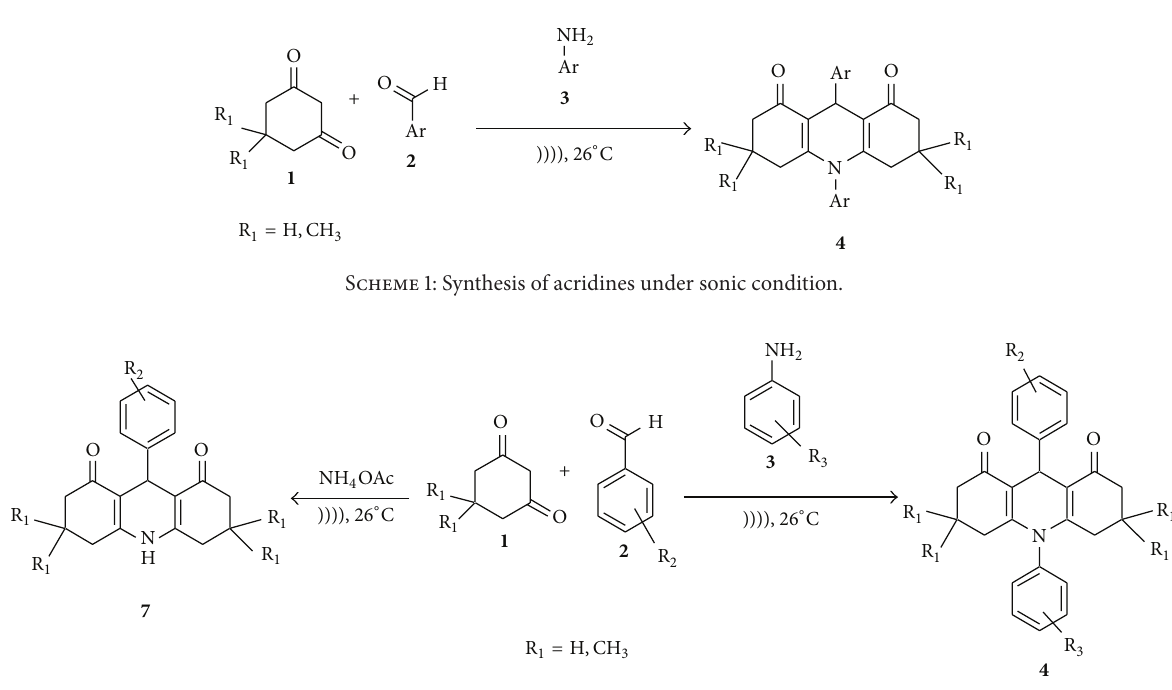
Scheme 2: Synthesis of N -H-acridines ( 7 ) and N -substituted acridines ( 4